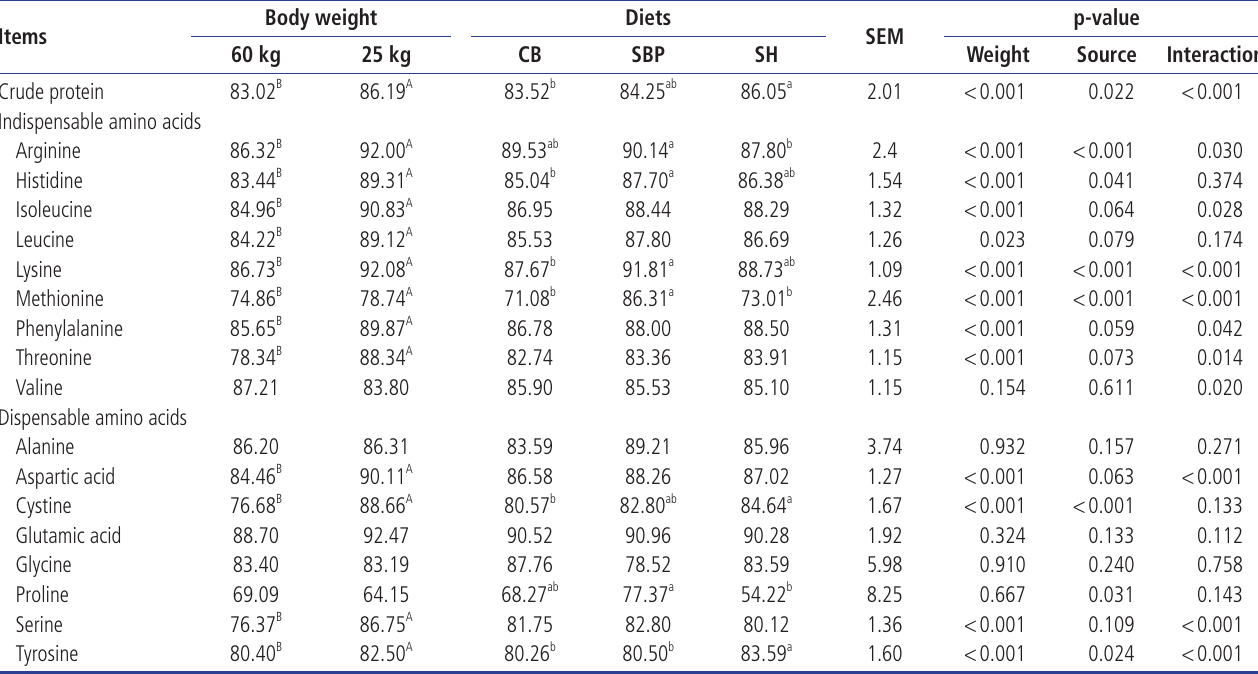
Table 5. Effects of pig body weight and fiber sources on the apparent ileal digestibility coefficient of amino acids 1)